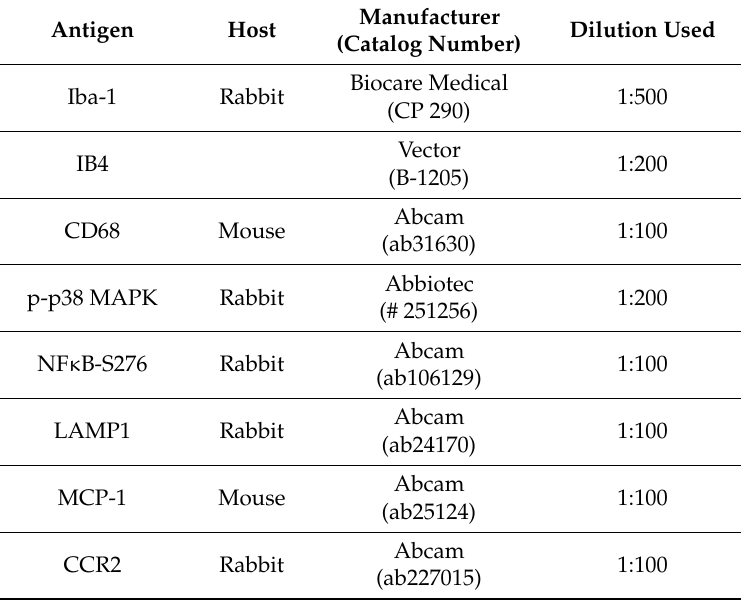
Table 1. Primary antibodies and lectin used in the present